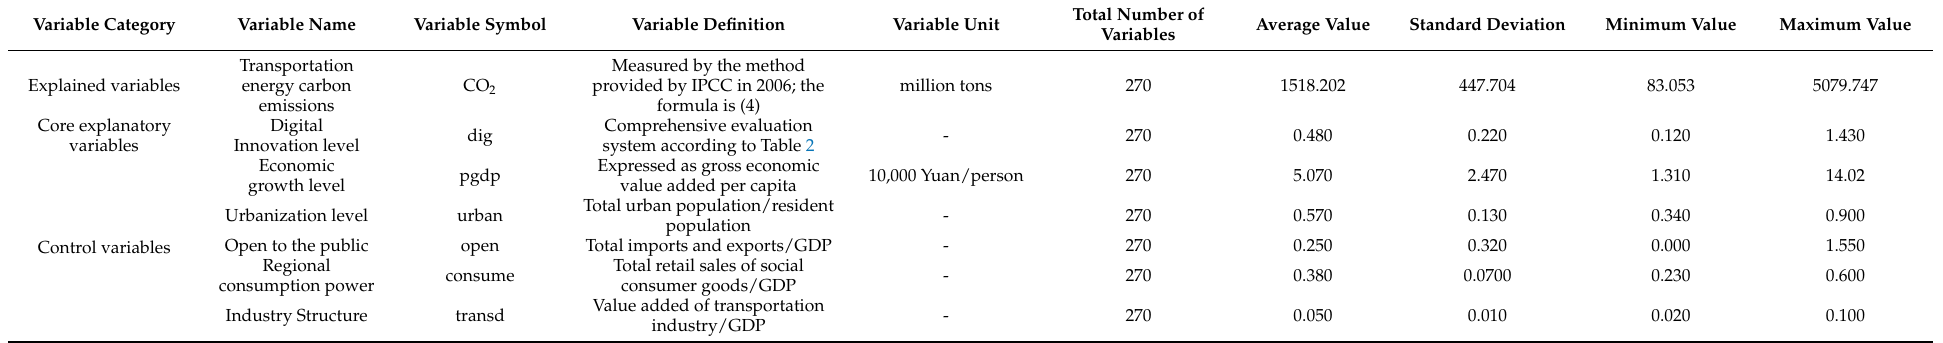
Table 3. Results of descriptive statistics for each